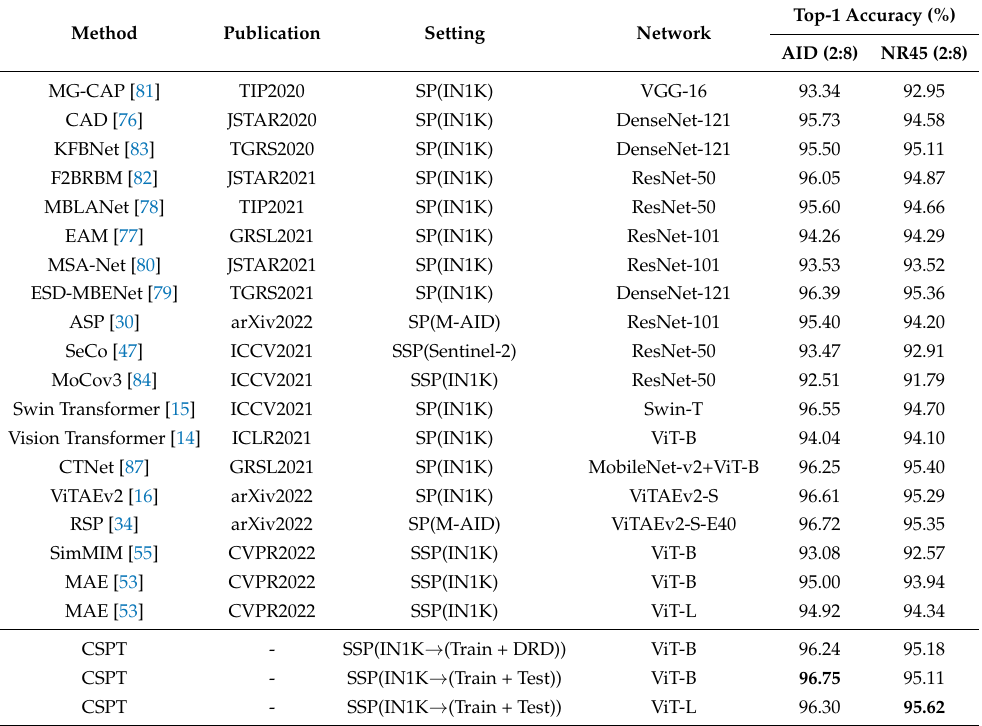
Table 5. The comparison results on AID [19] and NR45 [20]. The best results are marked in